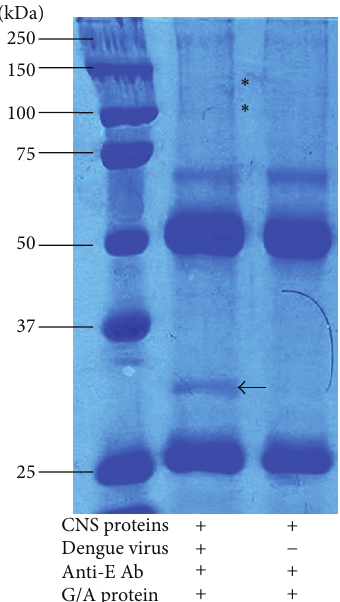
Figure 2: Coimmunoprecipitation of central nervous system (CNS) proteinswithdengueEviralprotein.Coimmunoprecipitationassays revealed that four CNS proteins consistently bound with dengue virus particles. One major protein with molecular weight of 32 kDa and other two minor proteins with molecular weights of 100 and 130kDawereobtained.Thesewerenotpresentinthecontrolwithno virus. Black arrows point to CNS protein bands that bound dengue virus E protein. ∗ Protein bands with a minor